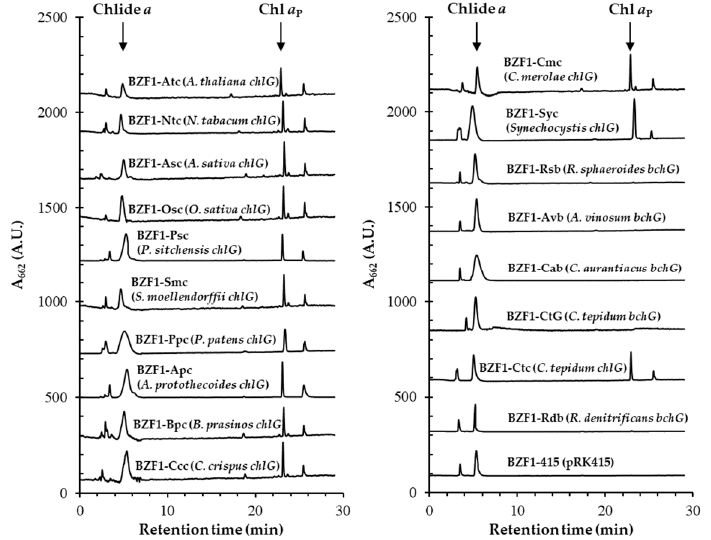
Figure 3. Formation of Chl a P in BZF1 expressing bchG s and chlG s from various PS organisms. BZF1 cells expressing bchG s and chlG s were cultured in the dark with 75 mM DMSO for seven days. Total pigments were extracted from the cells and subjected to HPLC analysis. Chlide a and Chl a P are indicated by arrows, which were detected by absorbance at 662 nm. A.U., Arbitrary Unit. Table 1. BchG and ChlG activities of enzymes annotated as BchG and ChlG from various PS organisms. Classification